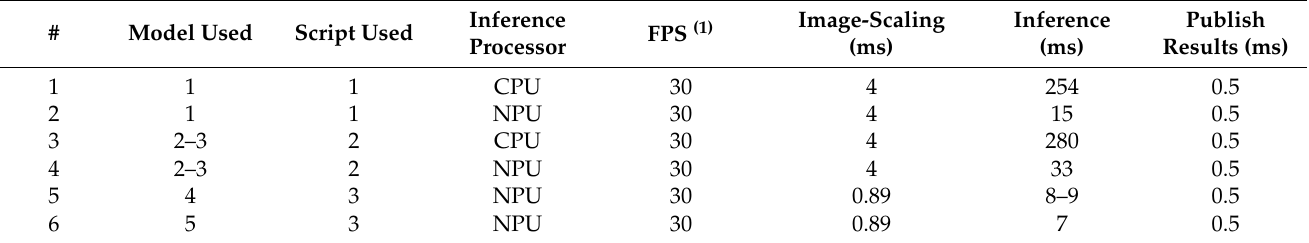
Table 3. Experiments results Summary. All times are in milliseconds.